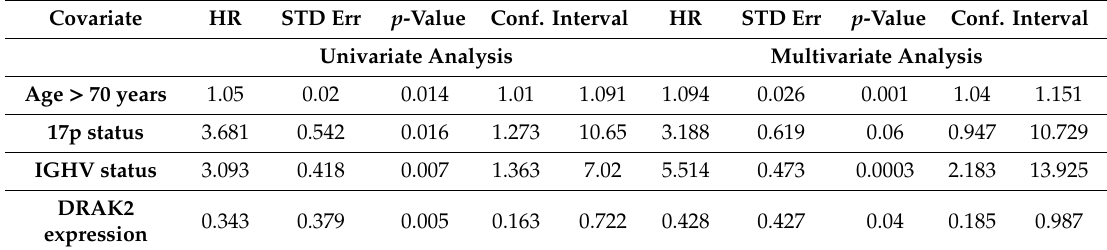
Table 2. Overall Survival analyses of the established CLL biomarkers (age, 17p deletion, and IGHV status) and the DRAK2